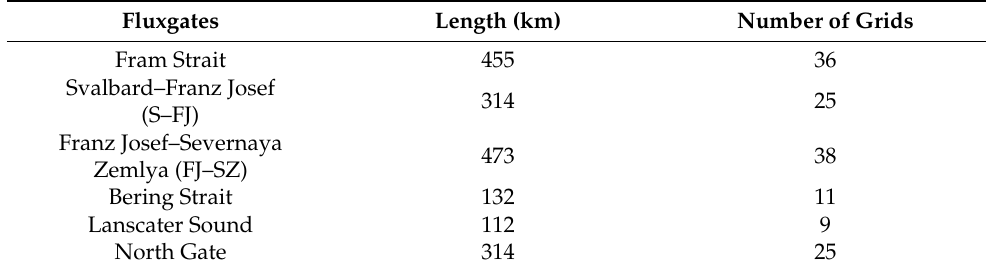
Table 2. Length and grid numbers of each gate. Fluxgates Length (km) Number of